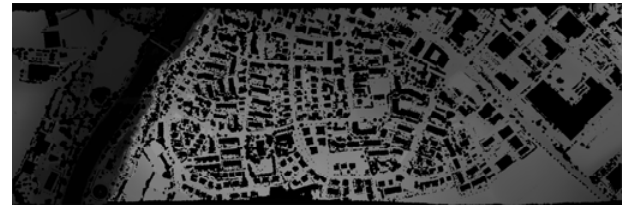
Figure 3. (b) terrain